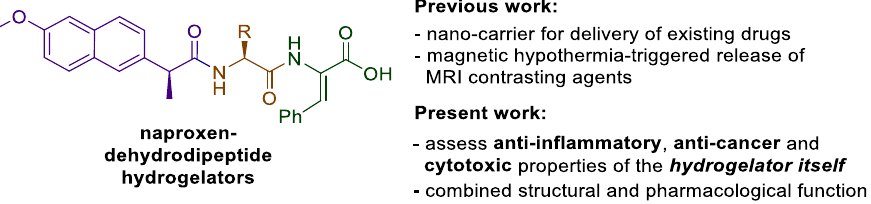
Figure 1. General structure of the hydrogelators to be studied.